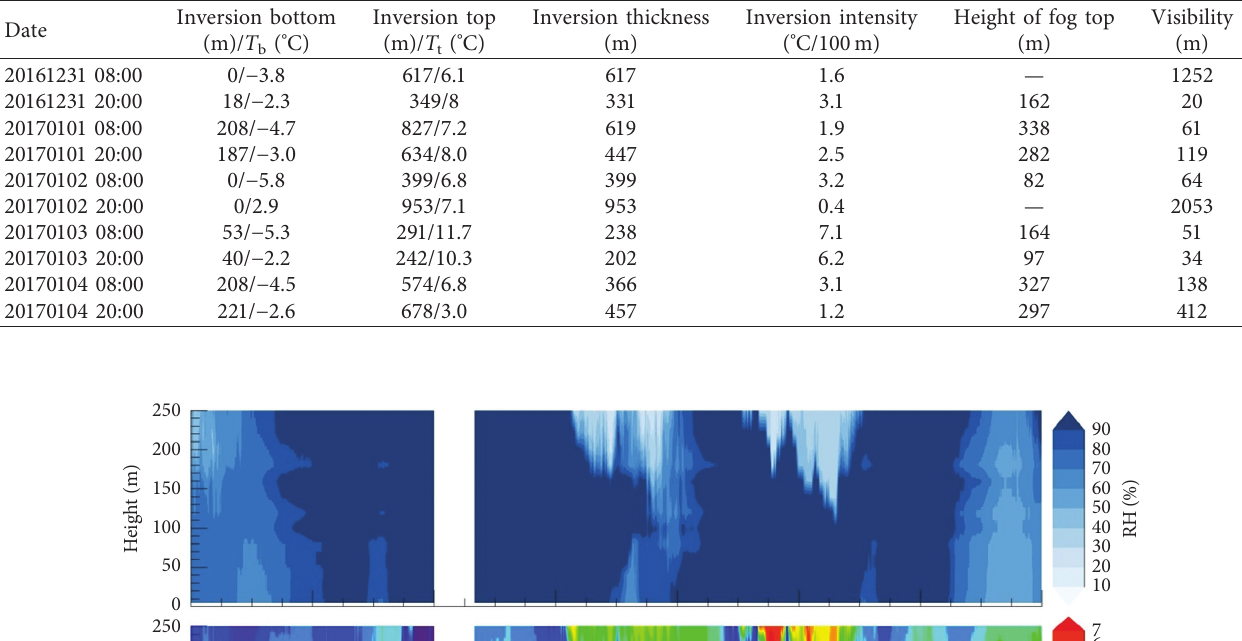
Table 2: Inversion characteristics of the boundary layer in the fog event of Xingtai Sounding Station.